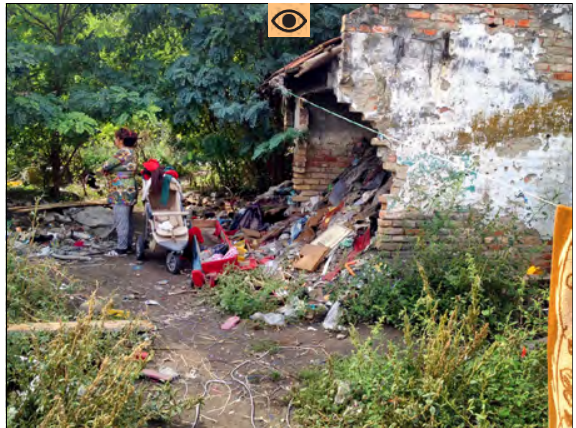
Figure 3. Demolished Roma house in